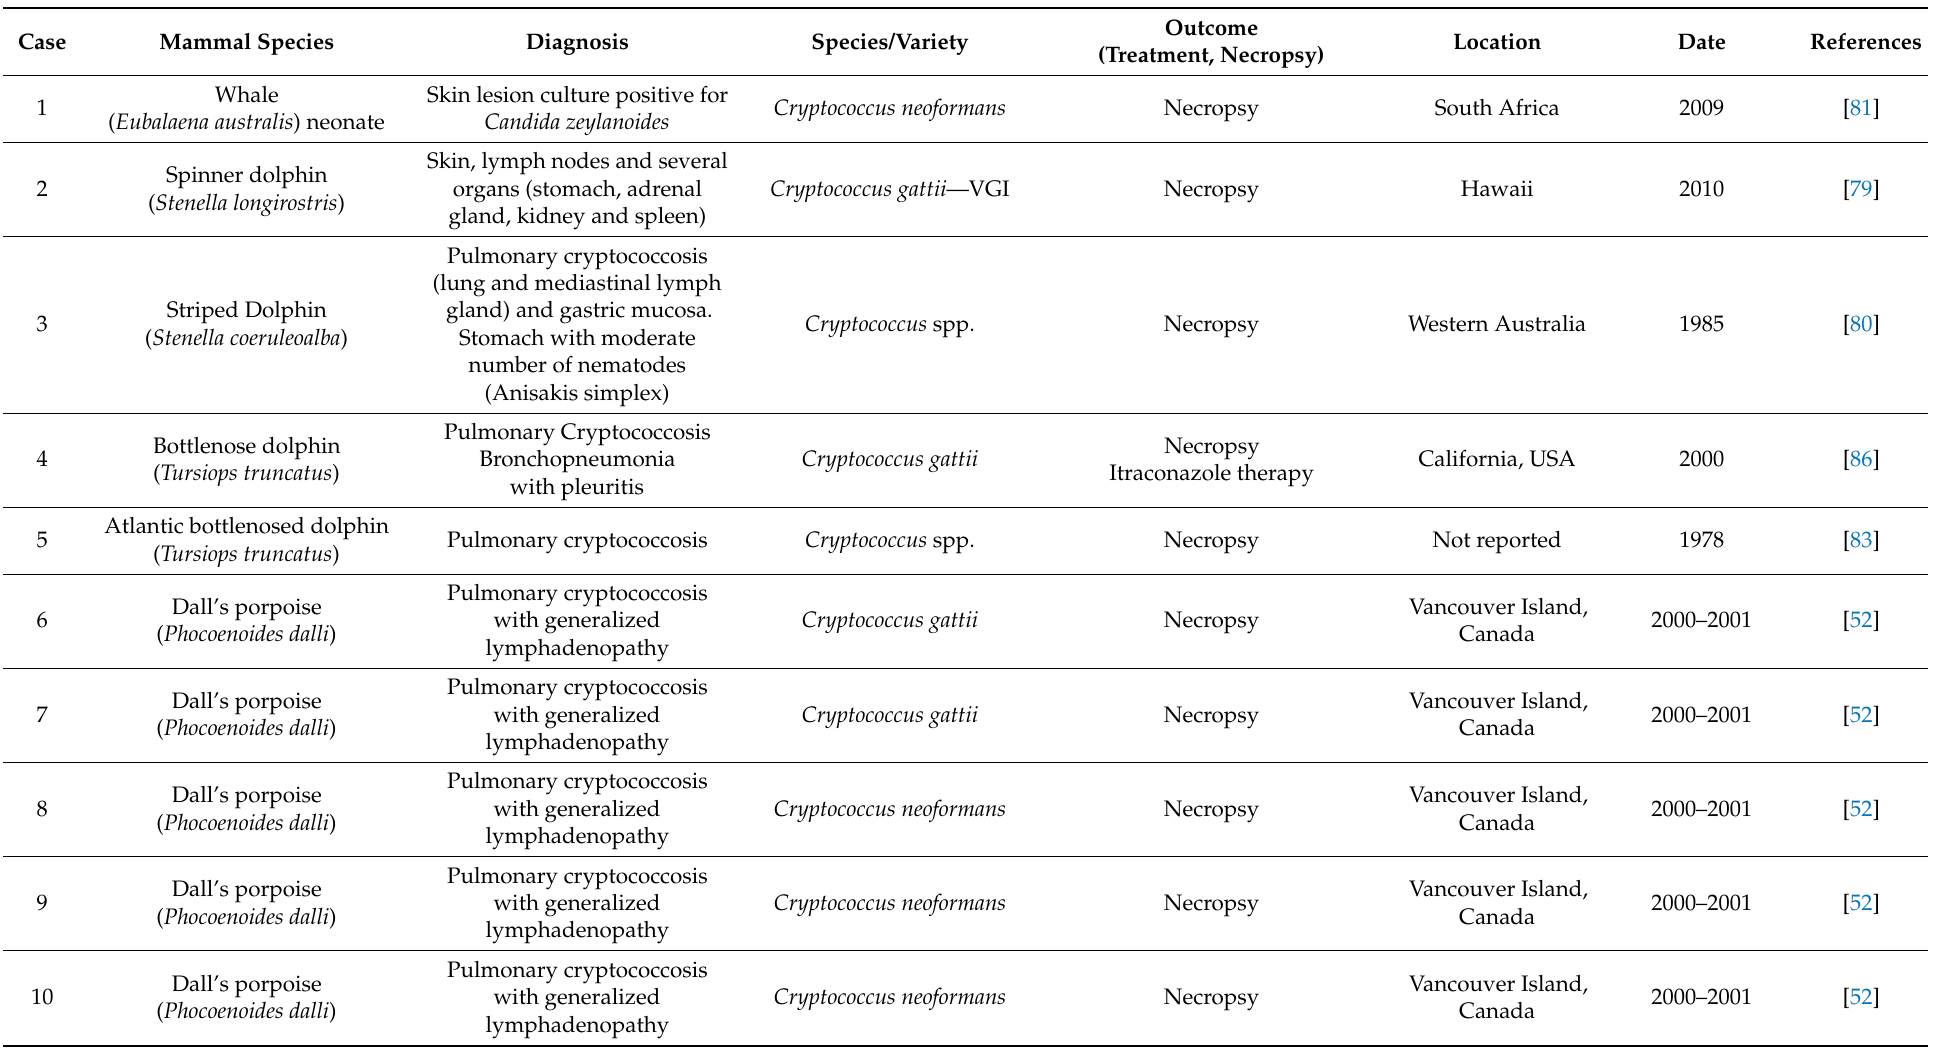
Table 2. Cryptococcosis in marine